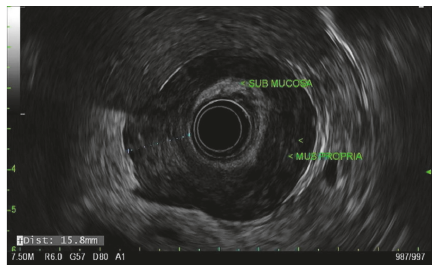
Figure 4: Immunohistochemical stain for GATA3, a lineage marker for breast origin.